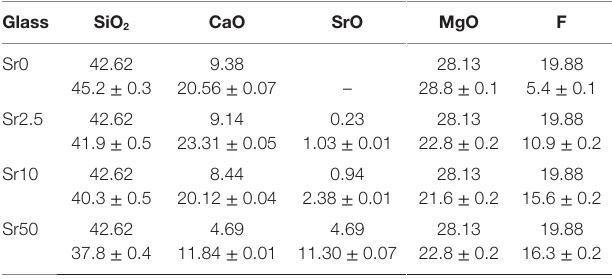
TaBle 2 | eDX results compared to nominal glass composition (mol%; fluoride content presented as F; ca and sr presented as oxides only).